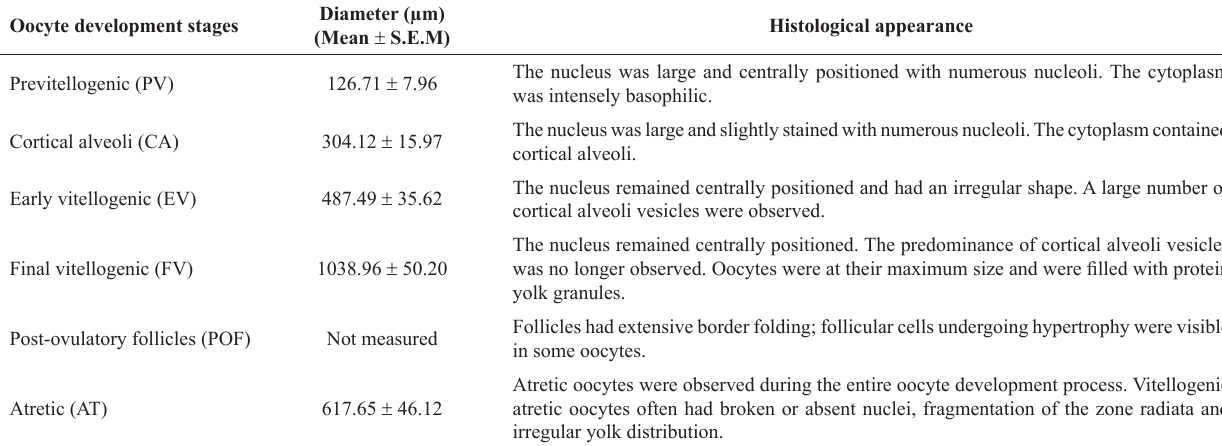
Table 2. Histological descriptions and oocyte diameters during different developmental